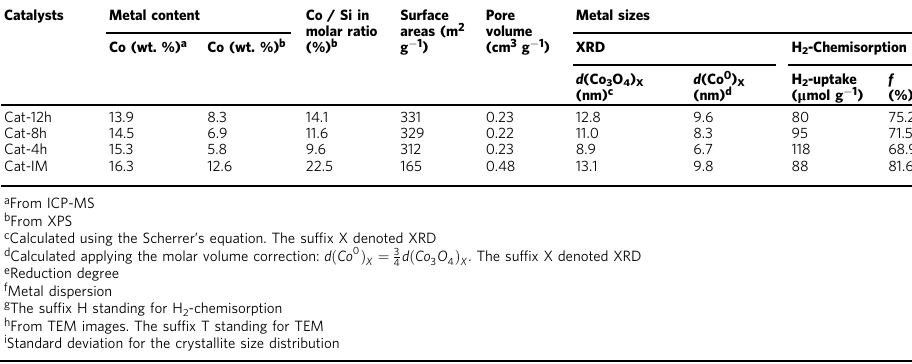
Table 1 Chemical and physical properties of the catalysts Catalysts